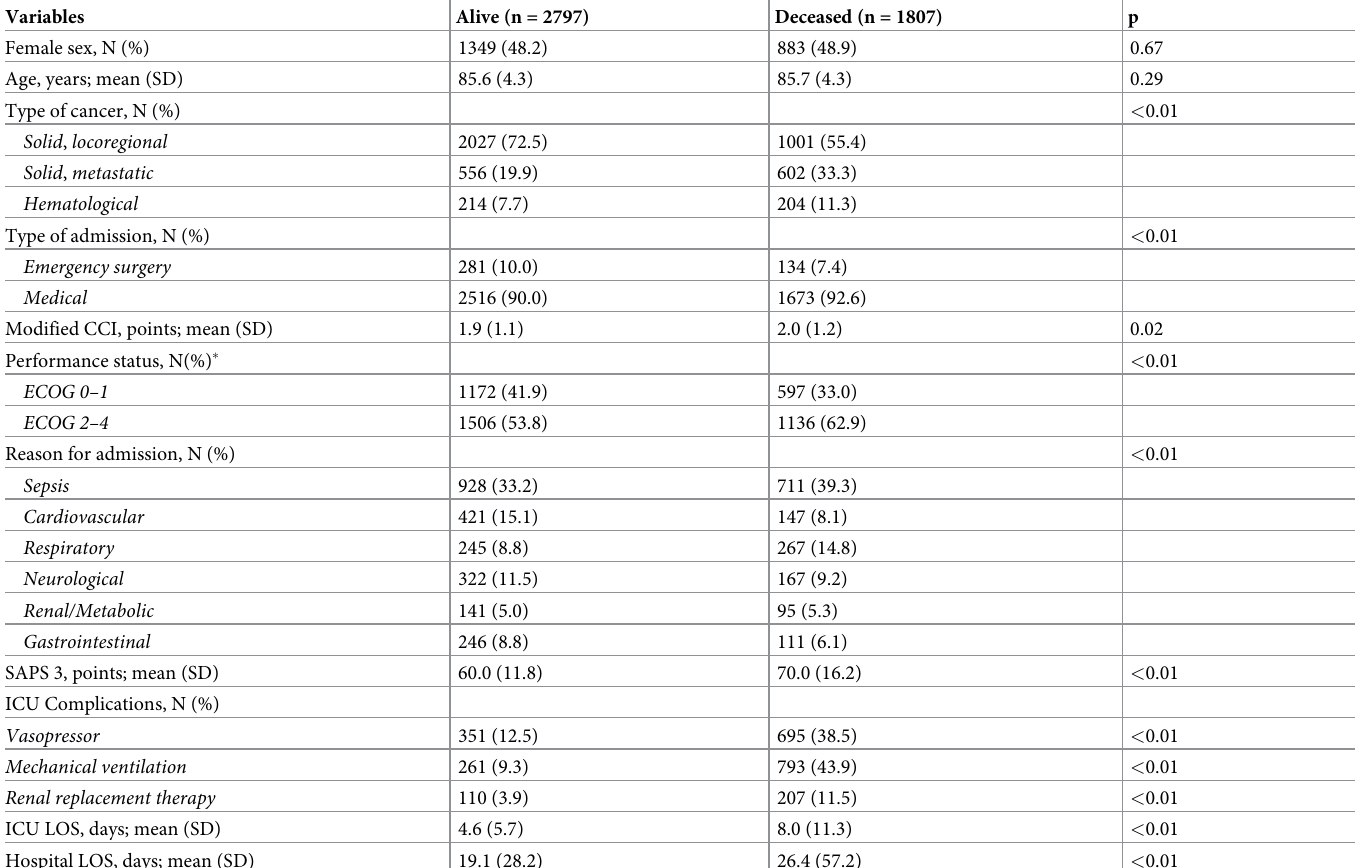
Table 1. Patients’